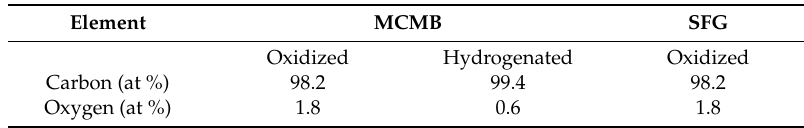
Table 2. X-ray photoelectron spectroscopy (XPS)-derived elemental analysis comparison of different functionalized MCMB and SFG graphite cathode